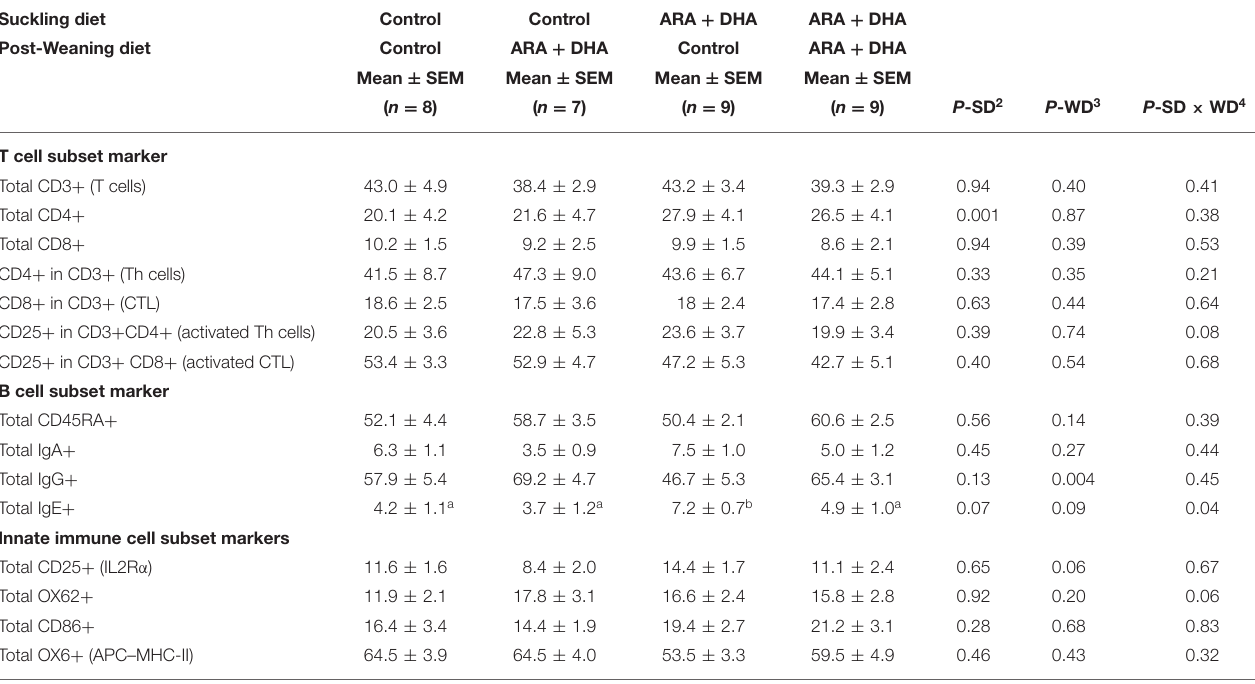
TABLE 6 | The effect of supplementing suckling diet and post-weaning diet on the composition of immune cell types isolated from the Peyer’s patches of 8-week-old Brown Norway offspring 1 . Suckling diet Control Control ARA + DHA ARA + DHA Post-Weaning